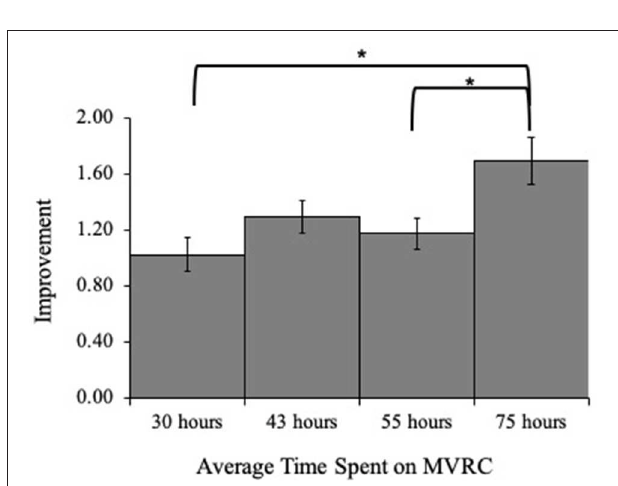
FIGURE 2 | Average improvement of 3rd-grade reading fluency, as a function of hours practiced (separated into quartiles). Error bars represent standard errors. *Significant difference obtained with Bonferroni pair-wise comparisons ( p < 0.05).